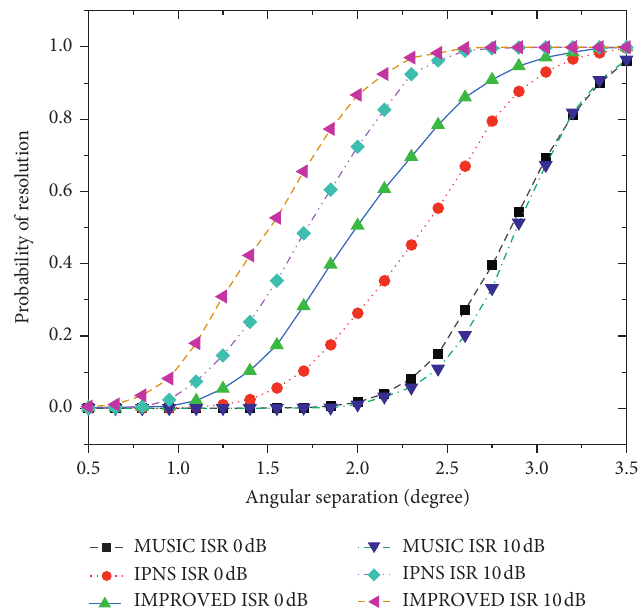
Figure 9: The probability of resolution against the angular separation under different ISRs.